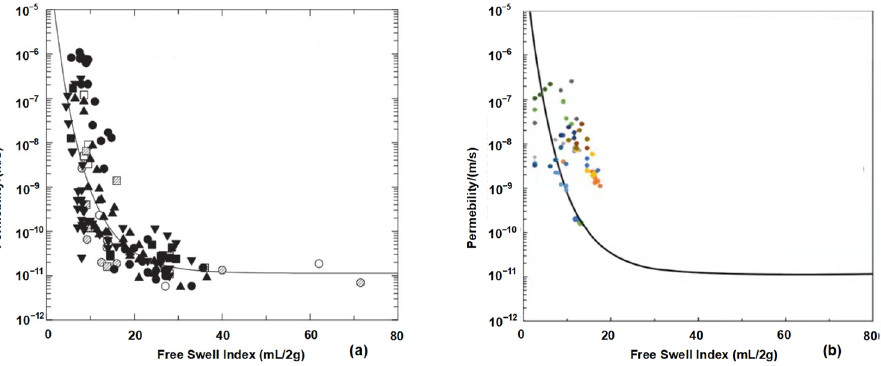
Figure 6. Relationship between the free swell index and permeability (( a ) from Katusmi and ( b ) from the data in this study).